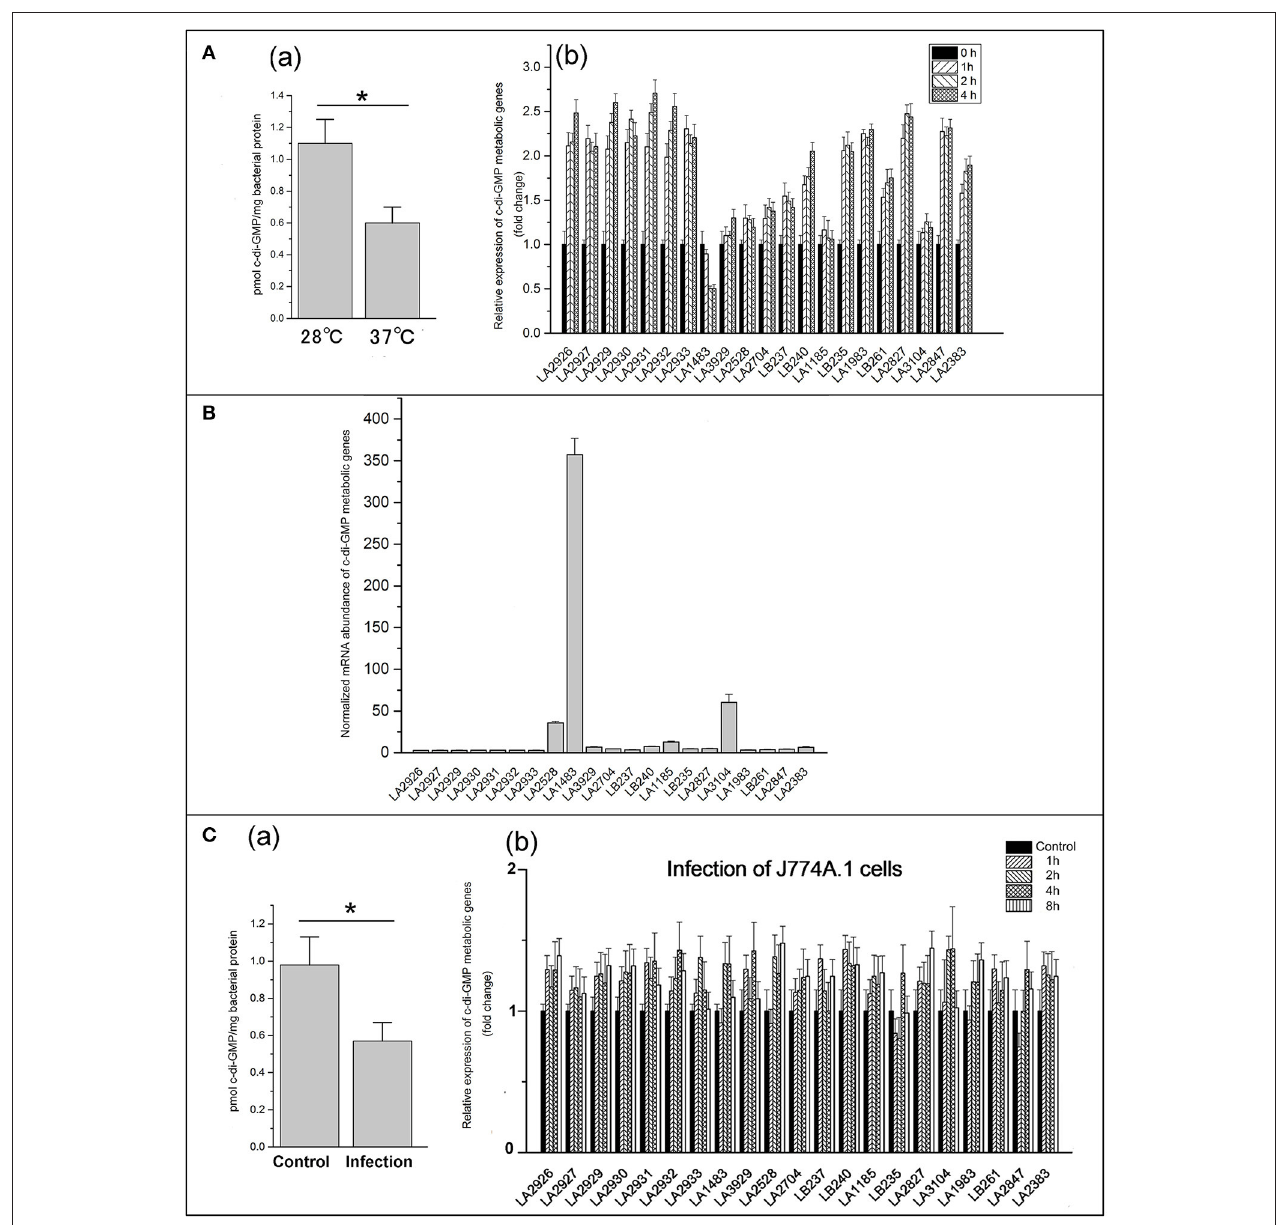
FIGURE 5 | C-di-GMP levels and the expression of c-di-GMP metabolic genes varies in response to environmental changes. (A) Effect of temperature-shift on c-di-GMP levels (a) and expression of c-di-GMP metabolic genes (b) ; (B) Normalized mRNA abundance of each c-di-GMP metabolic genes in L. interrogans ; C: Determination of c-di-GPM levels (a) and expression of c-di-GMP metabolic genes (b) in L. interrogans during infection of mouse J774A.1 cells. The expression of c-di-GMP metabolic gene was measured by real-time PCR. The concentration of c-di-GMP was measured by HPLC-MS/MS. Error bars indicate standard deviations of three biological replicates. P -values were calculated by the two-tailed Student’s t -test, * p <